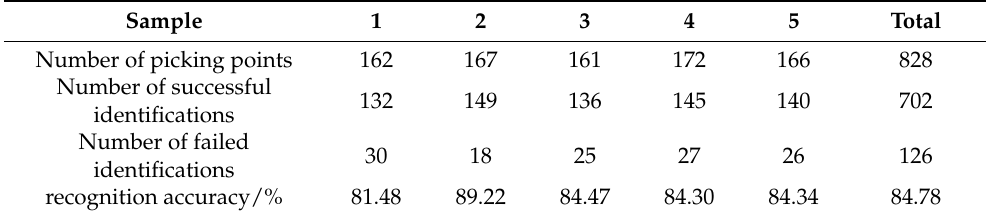
Table 10. Identification results of picking point for one bud with two